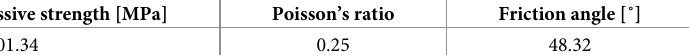
Table 2. Mechanical parameters of rock. Material Elastic modulus